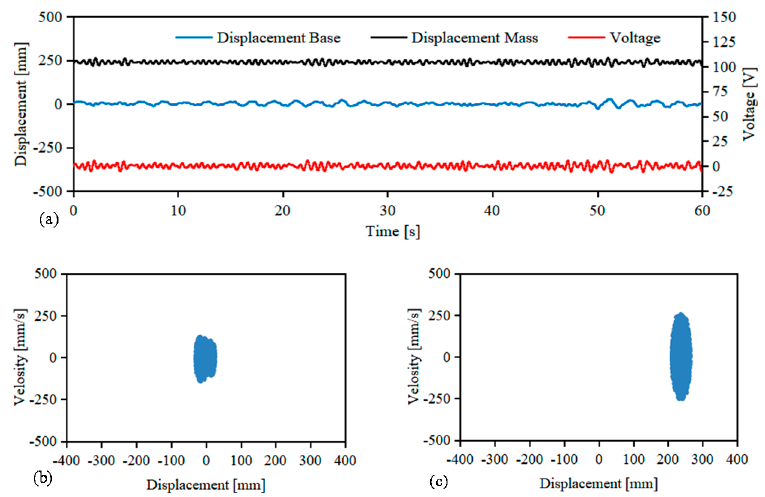
Figure 7. Measurement results of response vibration displacement and vibration power generation when vibrating with a random signal. ( a ) Results of response vibration displacement. ( b ) Diagram of displacement velocity of vibration of the support. ( c ) Diagram of displacement velocity of vibration of the mass block.